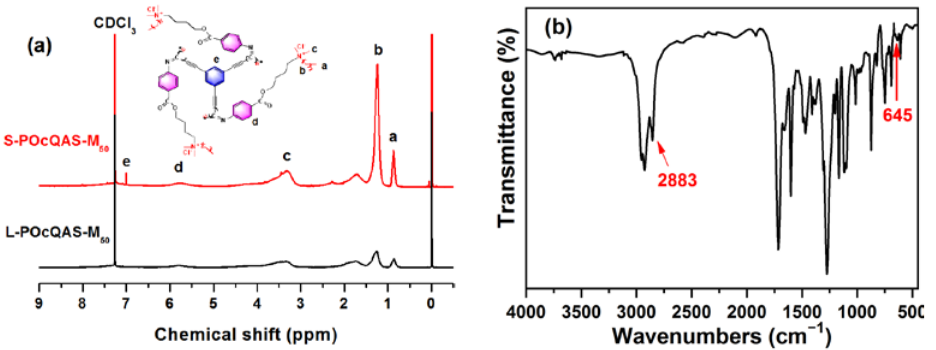
Figure 5. ( a ) 1 H NMR and ( b ) FT-IR spectra of S-POcQAS-M 50.